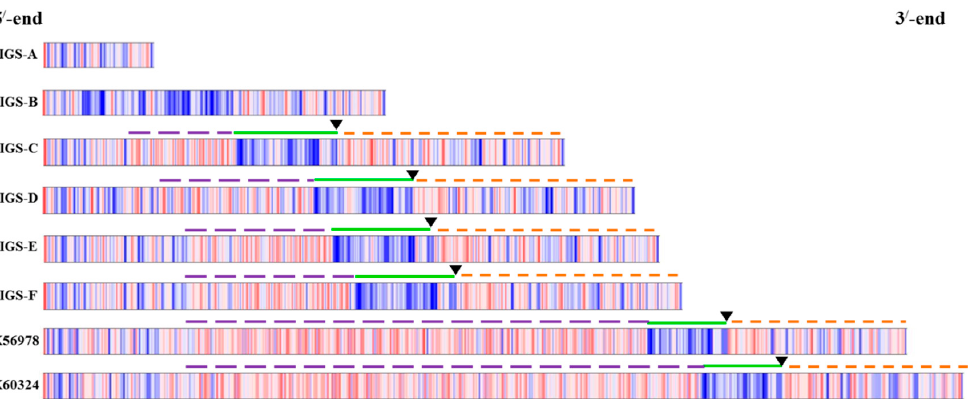
Figure 4. Functional elements and domains identified in the six IGS types. The transcription initiation site (TIS) of B. oleracea sequence is TATATAAGGGG (black down-arrow) for C, E, F and reference sequences X56978 and X60324, and that of the D type is TATATAAAGGG. Violet dashed line represents tandem repeat region, green line represents AT-rich region, orange dashed line represents ETS region, red and blue bars respectively represent the locations of GC and AT bases. The A and B types are devoid of tandem repeats, TIS and ETS. Transcription termination site is located at the beginning of 3’ end.